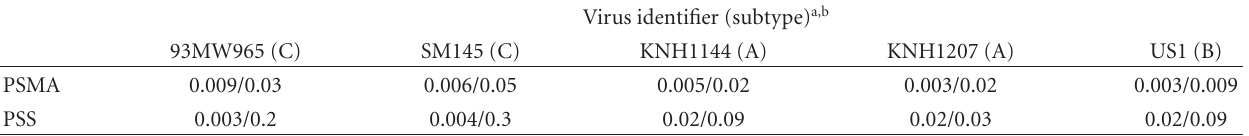
Table 1: alt -PSMA and PSS activity (IC 50 /IC 90 ) against clinical isolates of various